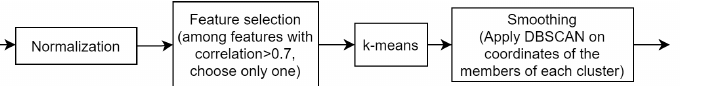
Figure 4. The clustering and smoothing pipeline (CaSP) for the management zone delineation approach of the current work. Algorithm 1: Smoothing